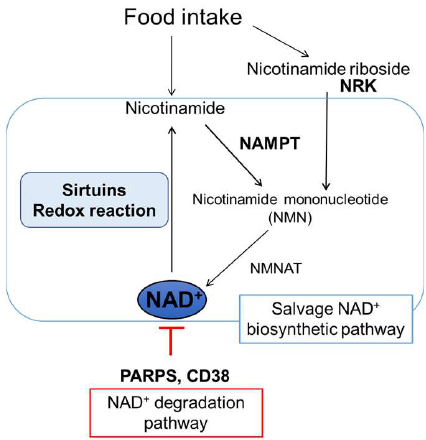
Figure 1. Mammalian NAD + biosynthetic salvage and degradation pathways. In mammals, NAMPT is the key enzyme in NAD + biosynthetic salvage pathway initiated from nicotinamide in food. SIRTs consume NAD + in a tissue-dependent manner, and NAD + degradation is me- diated by PARPs and CD38. NMNAT—nicotinamide/nicotinic acid mononucleotide adenylyl- transferase; NRK—nicotinamide riboside kinase; NAMPT—nicotinamide phosphoribosyltrans- ferase; SIRTs—sirtuins; PARPs—poly ADP ribose polymerases; CD38—cluster of differentiation 38; NAD + —nicotinamide adenine